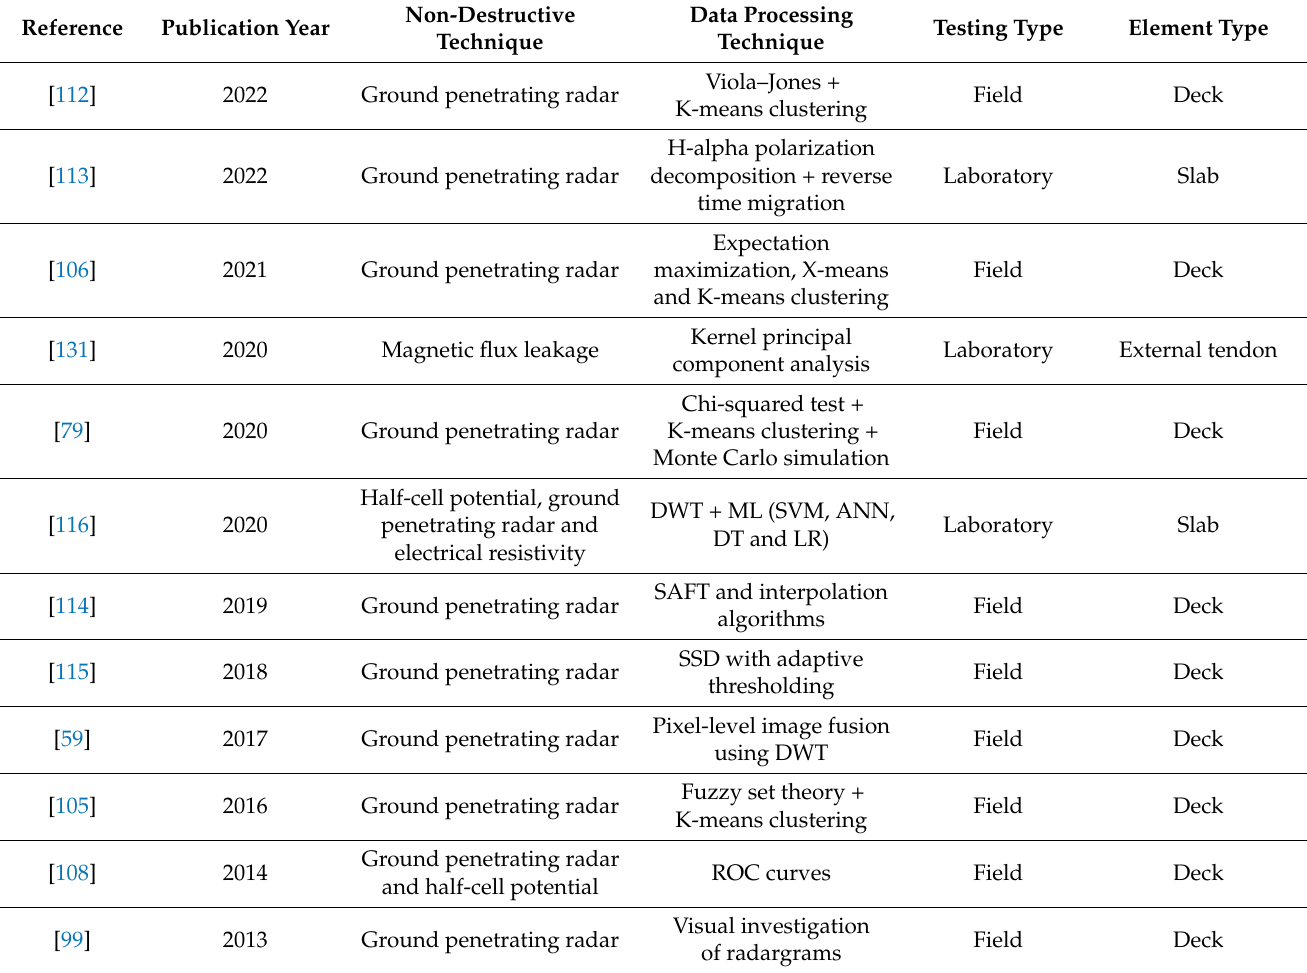
Table 13. Summary of some of the research studies devoted to corrosion